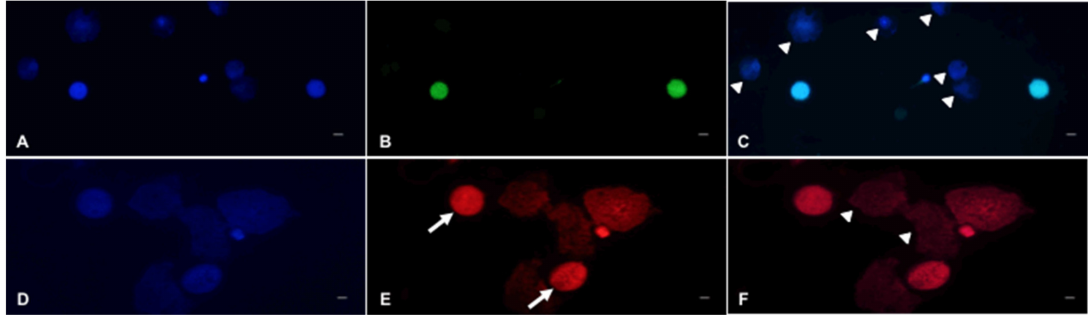
Figure 5. Proportions of cells with DNA fragmentation ( A ) and viable cells ( B ) in fresh, vitrified / warmed (warming), or vitrified / warmed / cultured (cultured 24 h) testicular tissues from black-footed ferrets. Data are expressed as mean ± SE ( n = 5 animals per treatment). Di ff erent letters above bars indicate significant statistical di ff erences between treatments ( p < 0.05).